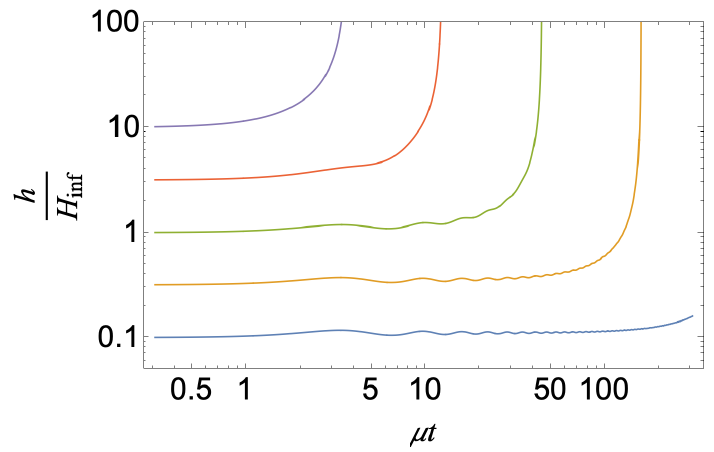
Figure 2. Evolution of the Higgs amplitude after inflation, taking h ( t ∗ ) = 0 . 1 H inf (blue), 0 . 3 H inf (orange), H inf (green), 3 H inf (red), and 10 H inf (purple), from the bottom to the top. The non- minimal coupling is taken to be ξ = 0